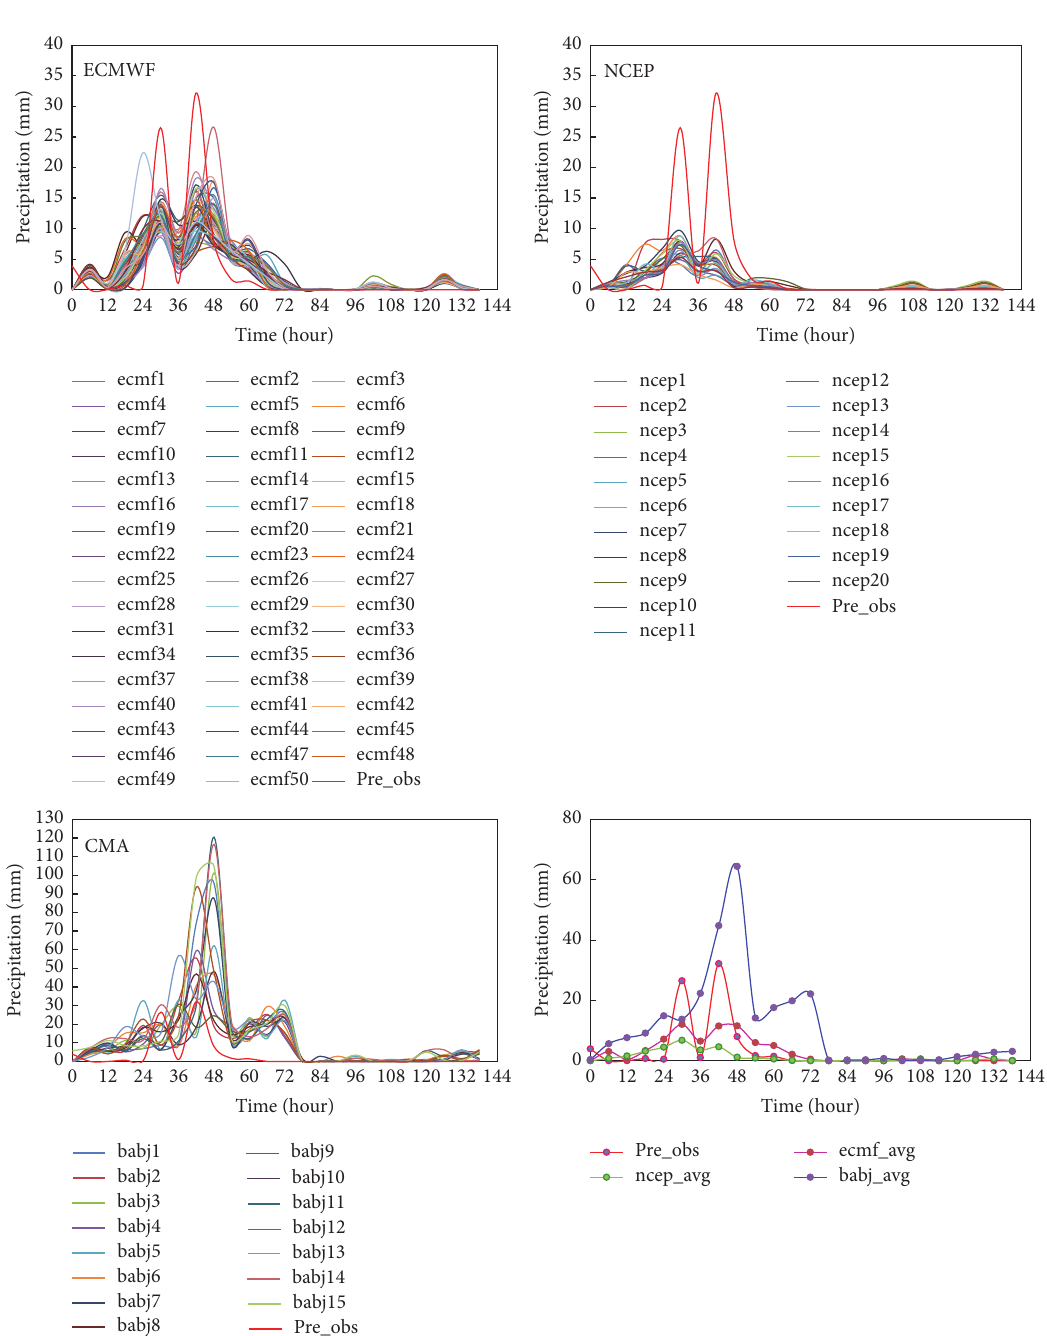
superensemble forecasts (figure not shown).